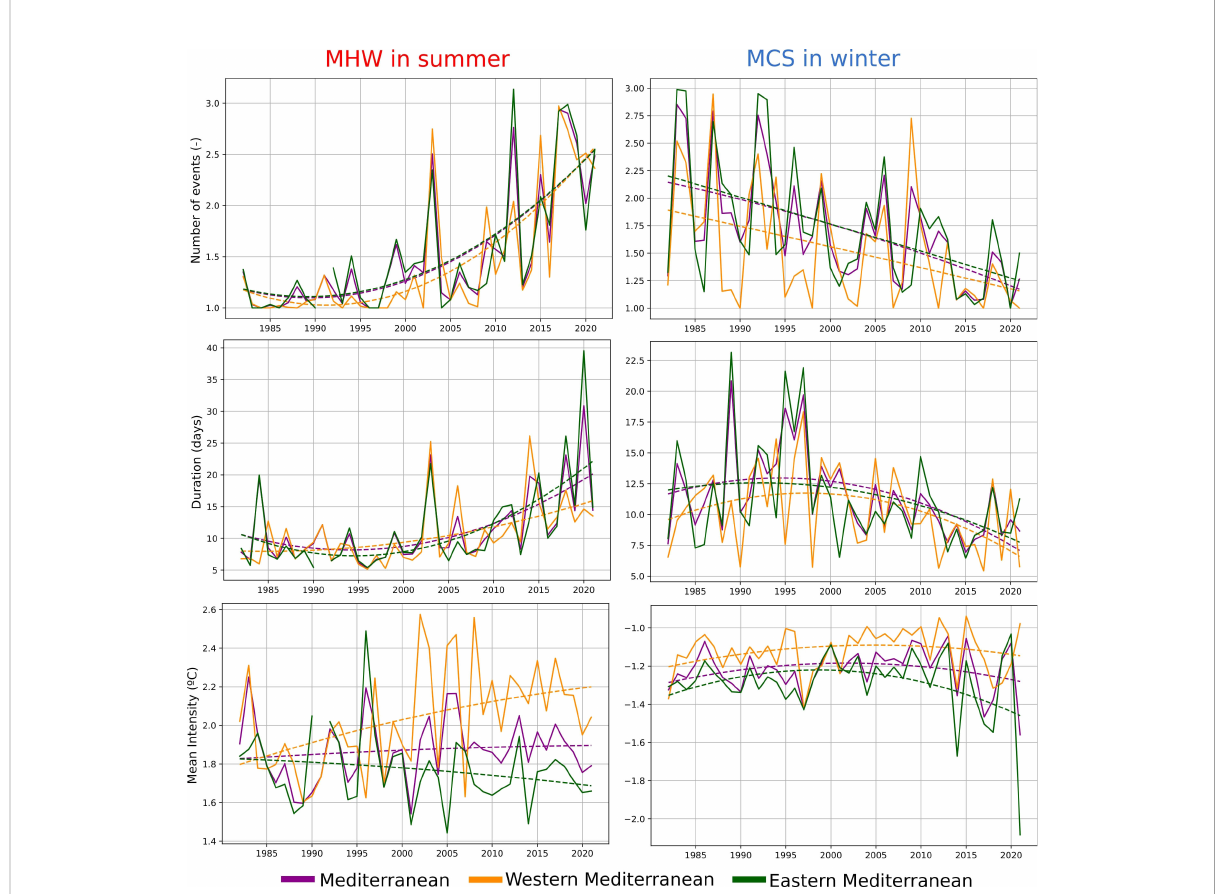
FIGURE 5 Times series of mean number (top), average duration (middle; in days), average intensity (bottom; in °C) of the MHWs in JJAS (left) and MCSs in DJFM (right) in the Mediterranean (magenta line), the western Mediterranean (orange line) and the eastrern Mediterranean (green line). Dash lines represent quadratic regression of the solid line with the same